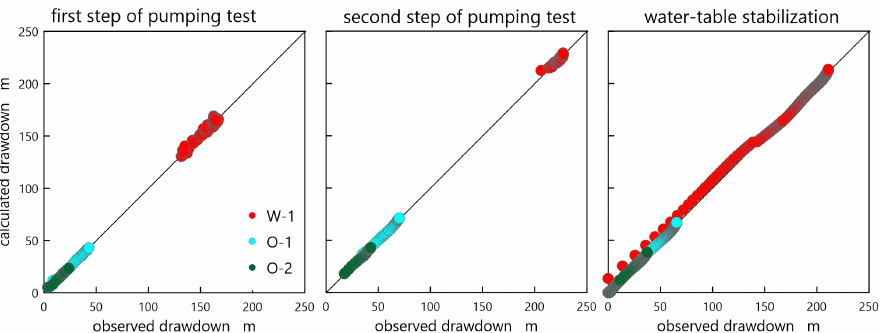
Figure 13. The plot of measured borehole depression vs. value calculated by the